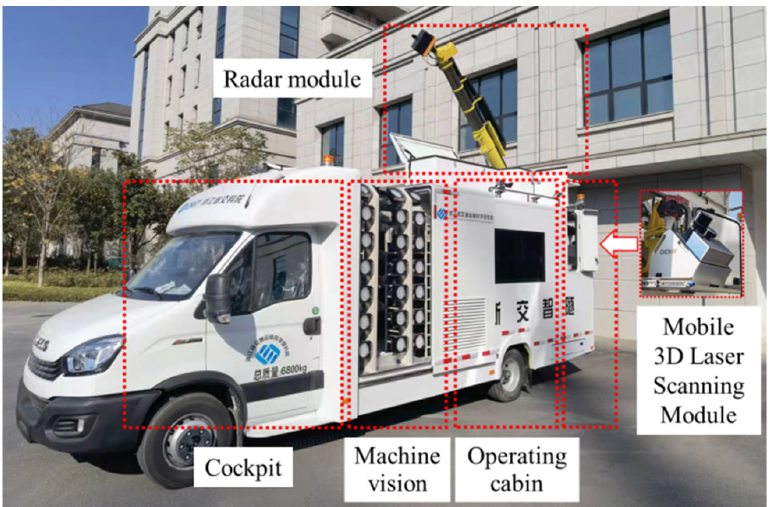
Figure 1. The tunnel fast-moving detection system composed of the cockpit, control cabin machine vision module, etc. Figure 2. The composition of the machine vision module of the tunnel inspection vehicle. The energy supply system consists of a silent generator and an uninterruptible power supply equipped with battery packs. The UPS battery pack is responsible for powering the energy supply and storage control systems. The silent generator can directly supply power for the compensation light source and charge the UPS battery pack. The control storage module comprises an industrial computer, an encoder, and five Next Unit of Com- putings. The industrial computer is responsible for calculating and setting the rotating platform, lens, and camera parameters. In addition, the shooting effect can be previewed in the industrial computer. Due to the large number of cameras and the high acquisition frame rate, the amount of image data that need to be stored in unit time is vast. The method of distributed acquisition and storage by five Next Unit of Computings is adopted Tunnel inspection vehicle machine vision module